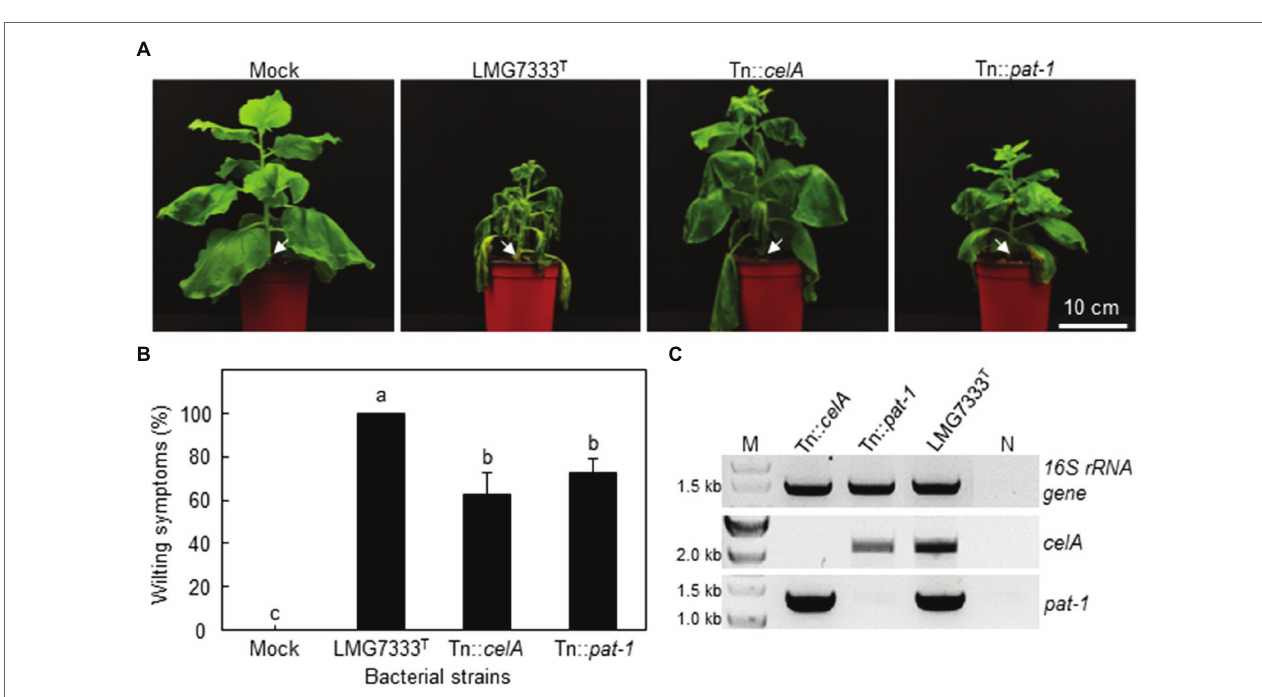
FIGURE 6 | Influence of two major virulence genes of C . michiganensis in N . benthamiana plants on the development of wilting symptoms. (A) Wilting symptoms in N . benthamiana after stem inoculation with 10 8 CFU/ml of C . michiganensis LMG7333 T and its Tn:: celA and Tn:: pat-1 mutant strains. Inoculation sites are indicated by white arrows. The inoculated plants were photographed at 21 days after inoculation (dai). (B) Quantification of wilting severity in N . benthamiana plants shown in (A). An average and standard deviation ( n = 4) of wilting severity are shown in the figures. The different letters on top of each bar indicate a statistically significant difference analyzed via Kruskal–Wallis test ( p < 0.05). Similar results were obtained from three independent assays. (C) Confirmation of inoculated bacteria via PCR analysis with primer sets specific to the indicated genes. M, 1 kb DNA marker; N, no DNA. Scale bar = 10